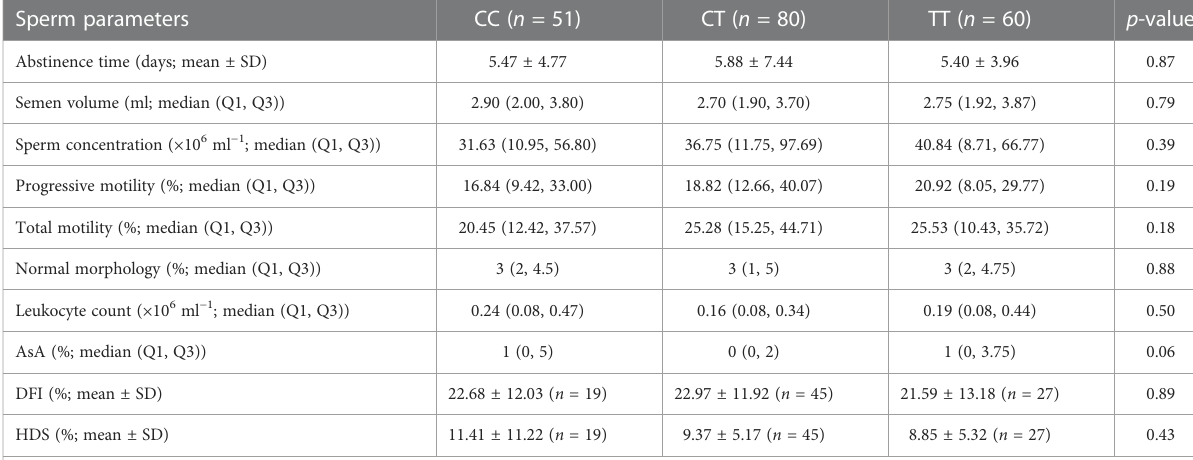
TABLE 3 Semen parameters of the study ’ s male population. Sperm parameters